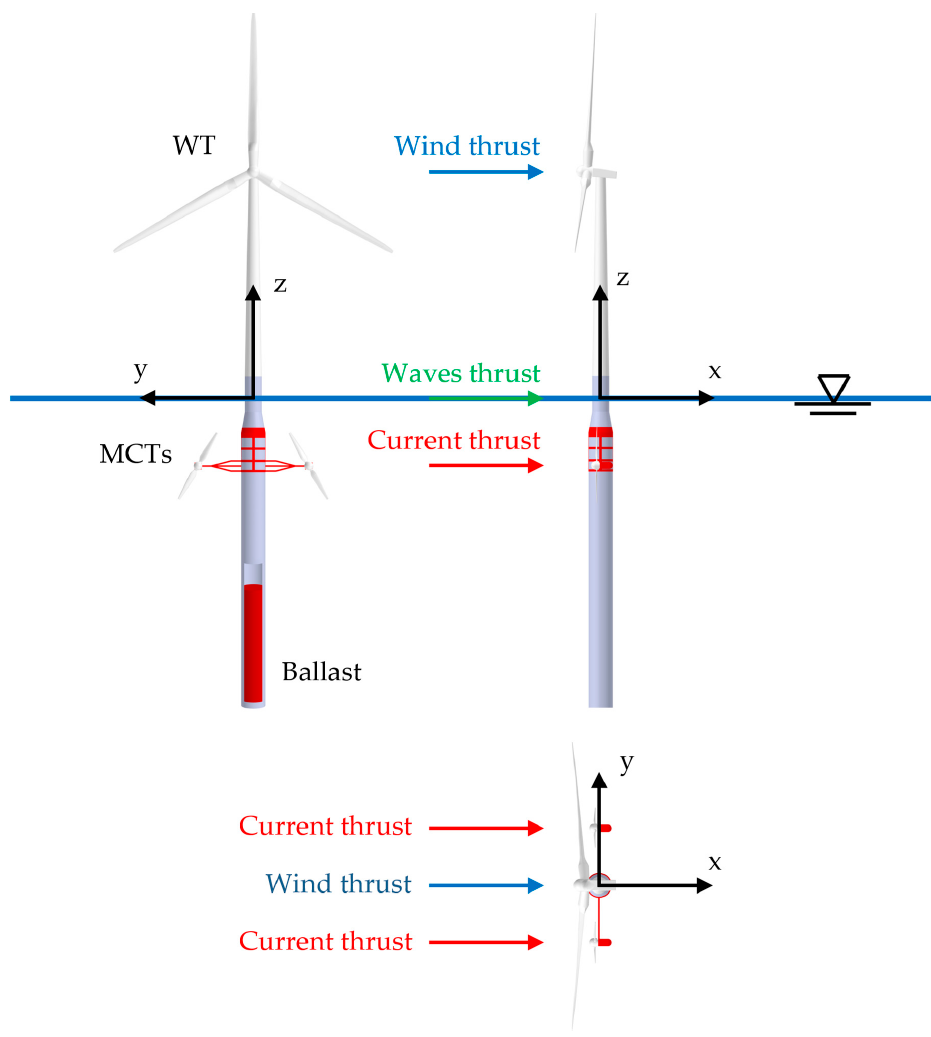
Figure 5. MICHEGER